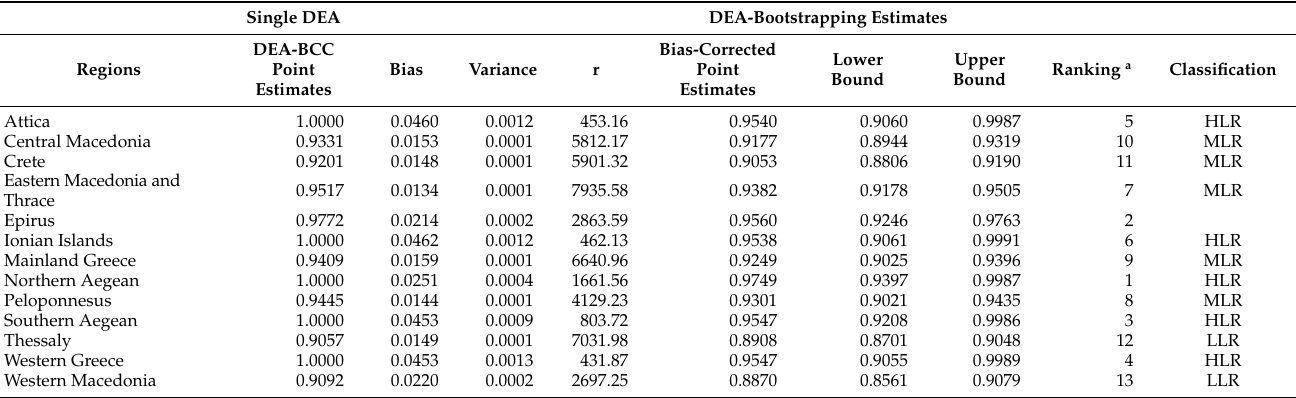
Table 2. Original DEA and bootstrapping